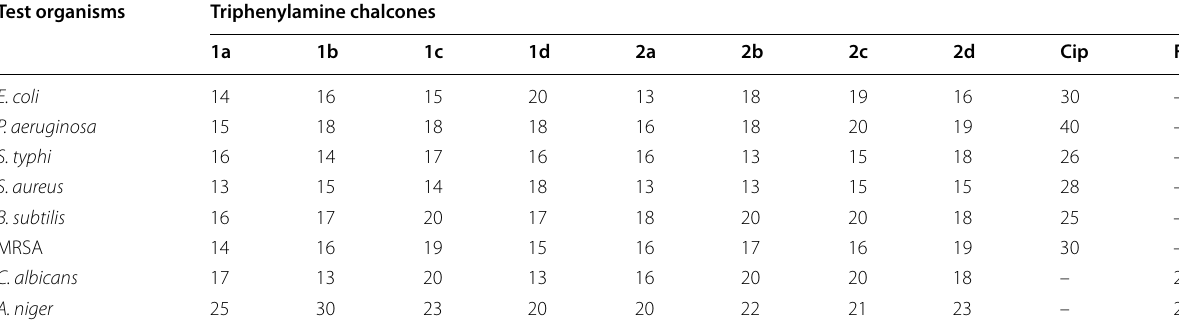
–: Not determined, Cip: ciprofloxacin, Flu: Fluconazole